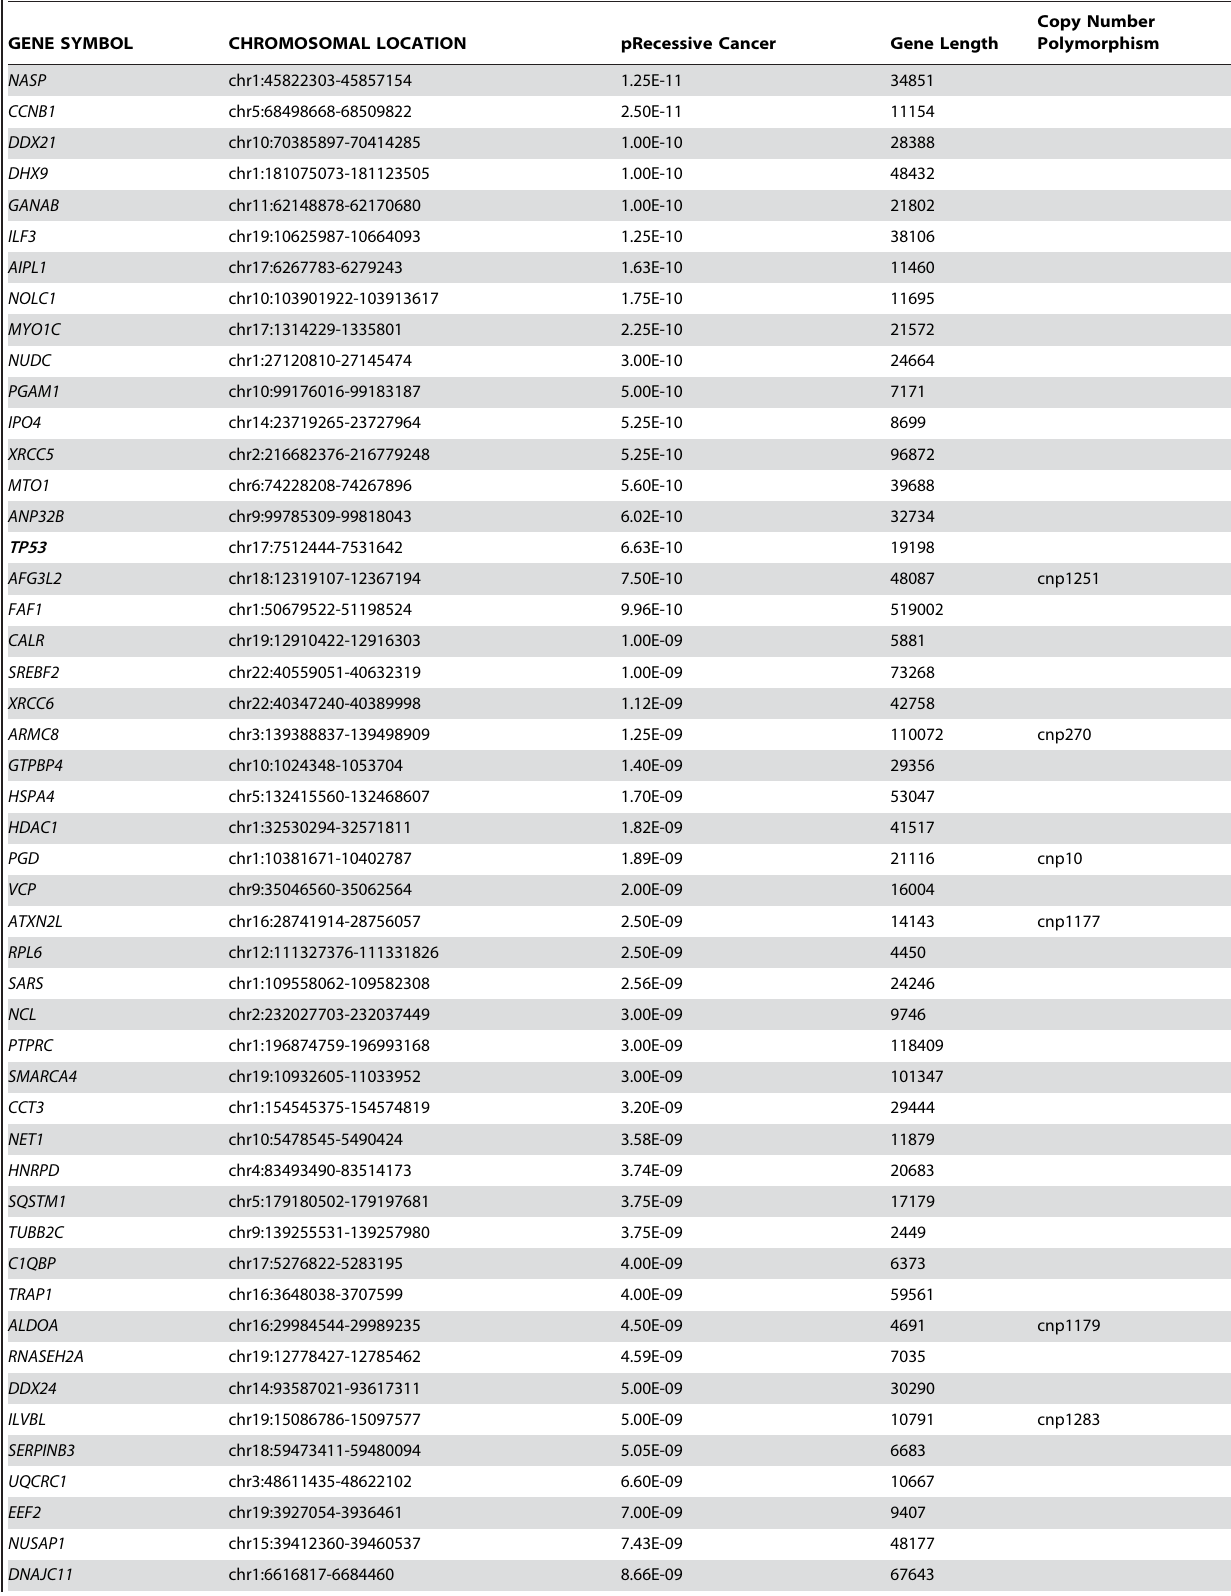
Table 2. The candidate recessive cancer genes with genomic location and associated copy number